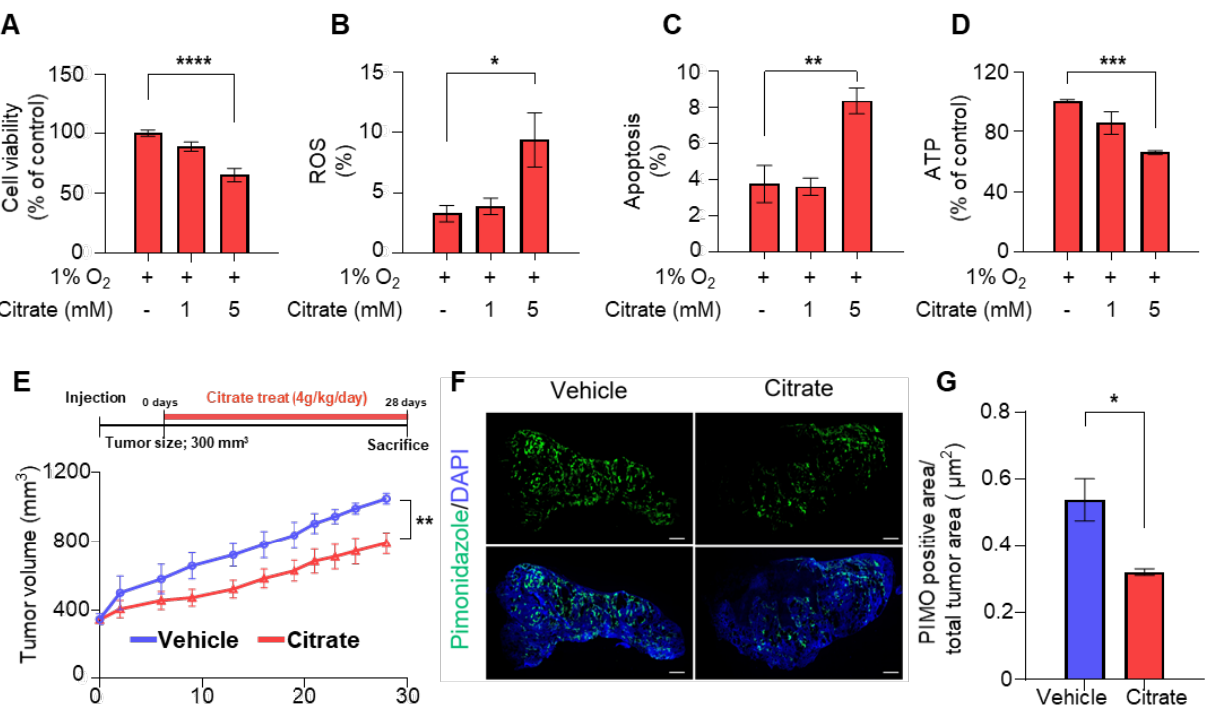
Figure 4. Anti-tumor effect of citrate in vitro and in vivo studies. ( A ) Cell viability in HepG2 cells following indicated treatment under 1% O 2 for 24 h. ( B ) ROS production was measured by flow cytometry using MitoSOX staining in HepG2 cells following treatment with the same as ( A ). ( C ) Rates of apoptosis (%) counted by flow cytometry following staining with Annexin V-fluorescein isothiocyanate and PI in HepG2 cells after treatment with the same as ( A ). ( D ) ATP levels in HepG2 cells after treatment with the same as ( A ). ( E ) The average tumor volumes of mice receiving drinking water supplemented with vehicle ( n = 5) or citrate (4 g/kg/day, n = 6) for 28 days. ( F ) Representative images of immunofluorescence staining with pimonidazole. ( G ) Quantification of the percentage of pimonidazole-positive area from vehicle ( n = 4) or citrate-treated ( n = 4) mice. Data represented as mean ± SEM and were compared using unpaired two-tailed t -tests and one-way ANOVA tests. * p < 0.05, ** p < 0.01, *** p < 0.001, **** p < 0.0001.